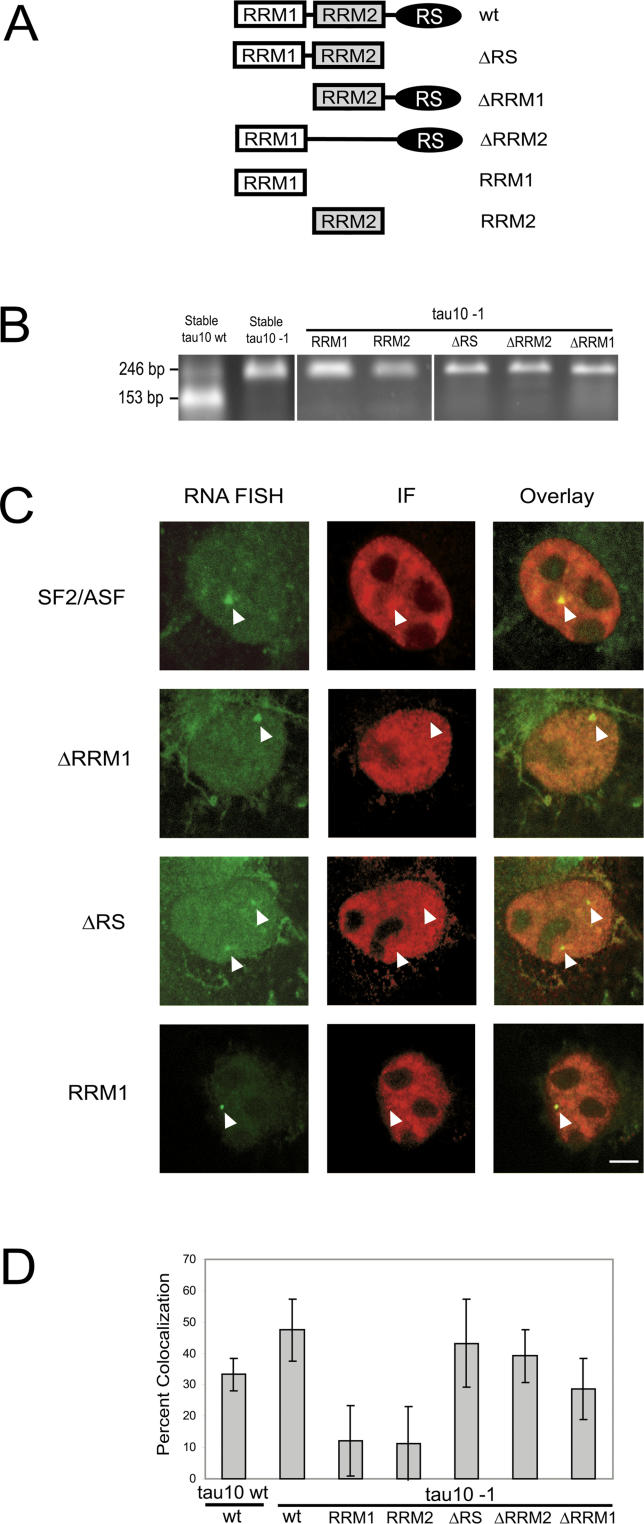
Deletion Mapping of Sf2/Asf Protein Domains Involved in Differential Recruitment(A) Schematic representation of T7-tagged mutants of SF2/ASF.(B) Semi-quantitative RT-PCR analysis of tau10−1 splicing upon expression of mutant SF2/ASF. Overexpression of the mutant proteins does not affect tau splicing.(C) Recruitment of splicing factors to tau transcription sites detected by combined RNA-FISH using specific probes against the tau minigene (green) and IF microscopy with anti-T7 antibody (red). Arrowheads indicate tau transcription sites. Scale bar = 2.5 μm.(D) Quantitation of percentage of cells with colocalization of tau RNA-FISH and splicing factor signals. Values represent averages from at least 50 transcription sites from three experiments ± SEM.